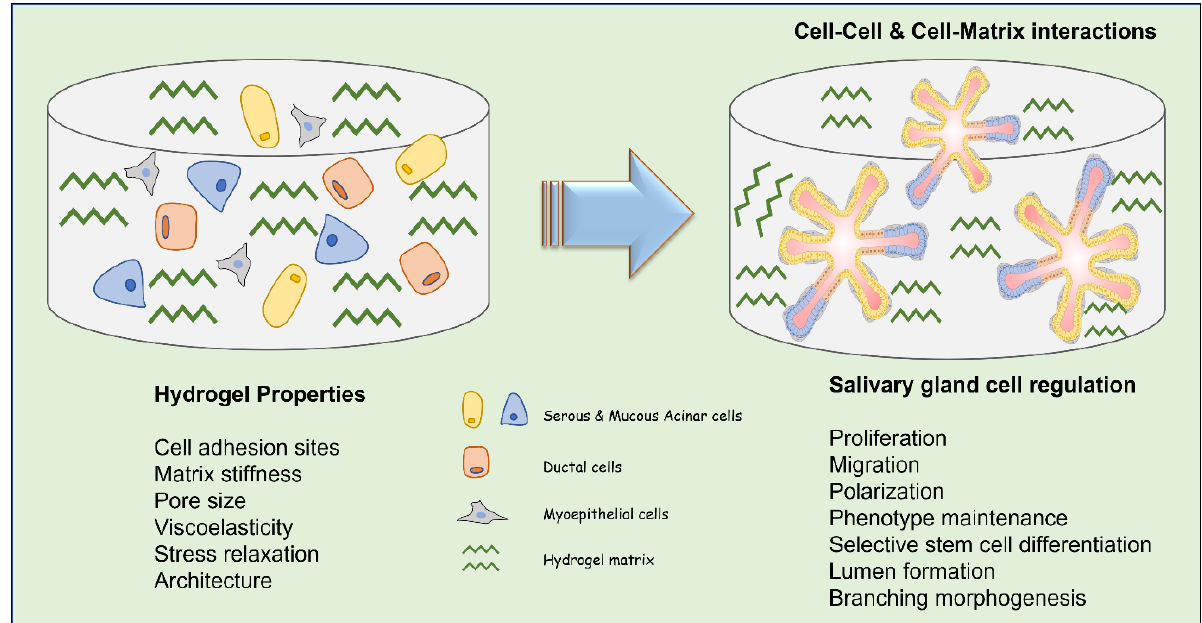
Figure 2. Schematic illustration of different types of SG cells within a hydrogel matrix describing the key hydrogel properties to be considered to adequately regulate cell functions for SG tissue engineering applications.